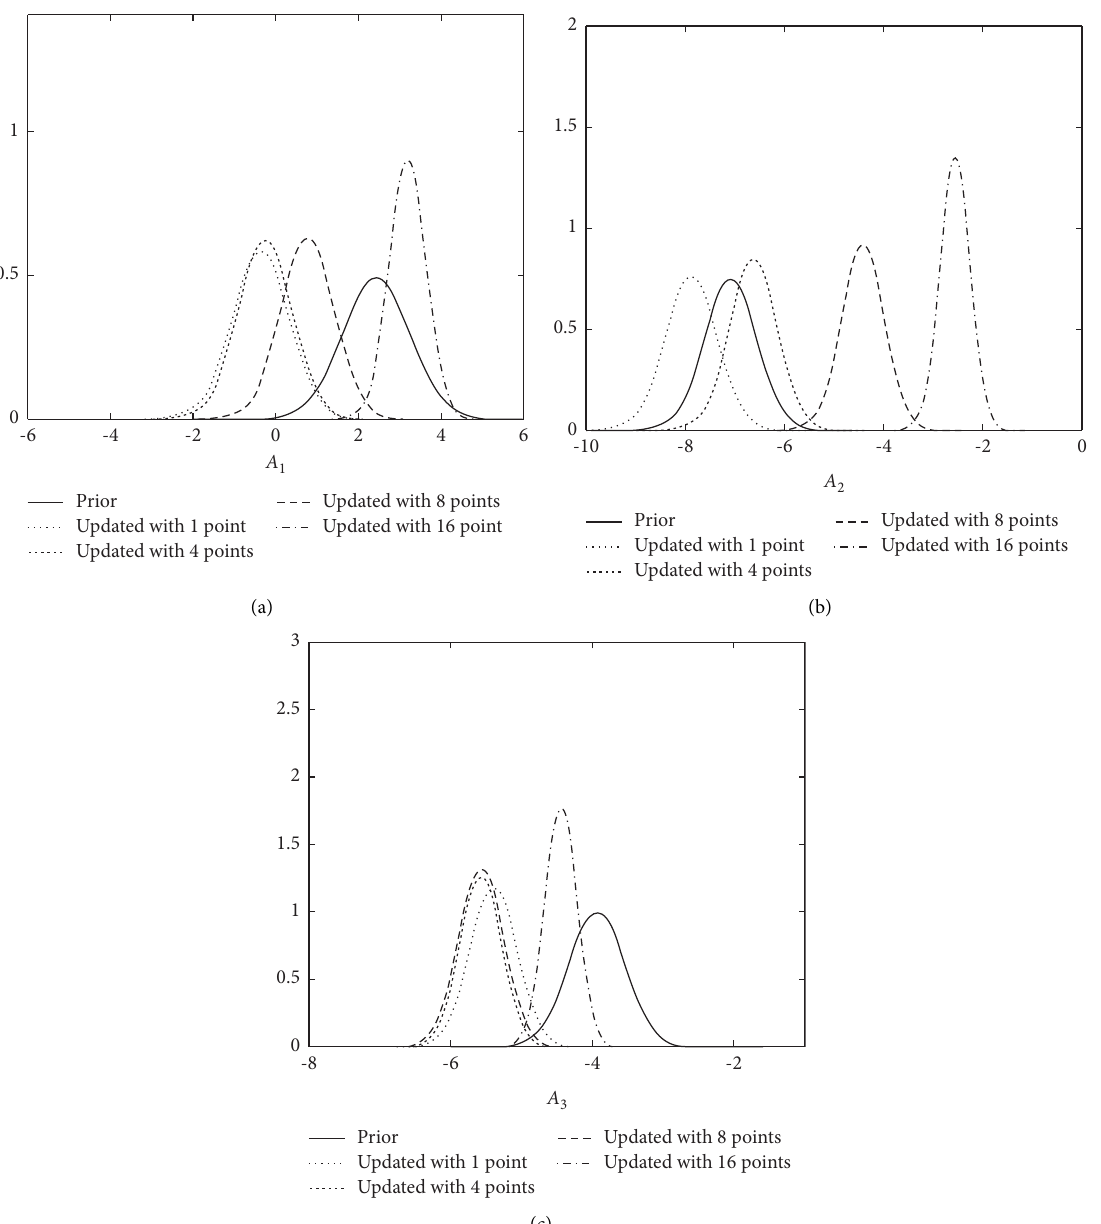
Figure 13: The prior and posterior distributions of model parameters (diameter: 10mm). (a) Parameter A parameter A 3